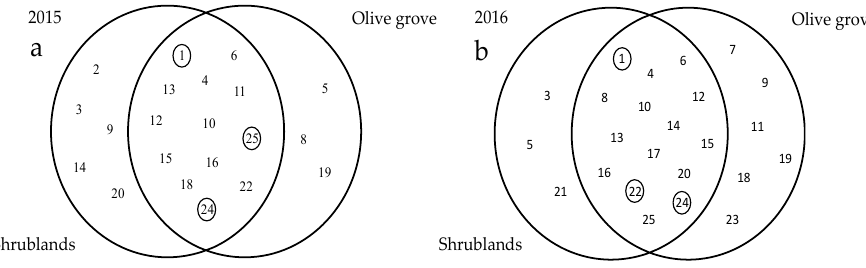
Figure 1. Complementarity of Coleoptera families in the Mirandela region (Northeast Portugal) in ( a ) 2015 and ( b ) 2016. Circles inside the Venn diagrams indicate the most abundant families. Numbers inside the Venn diagrams correspond to the families indicated in Table 1.